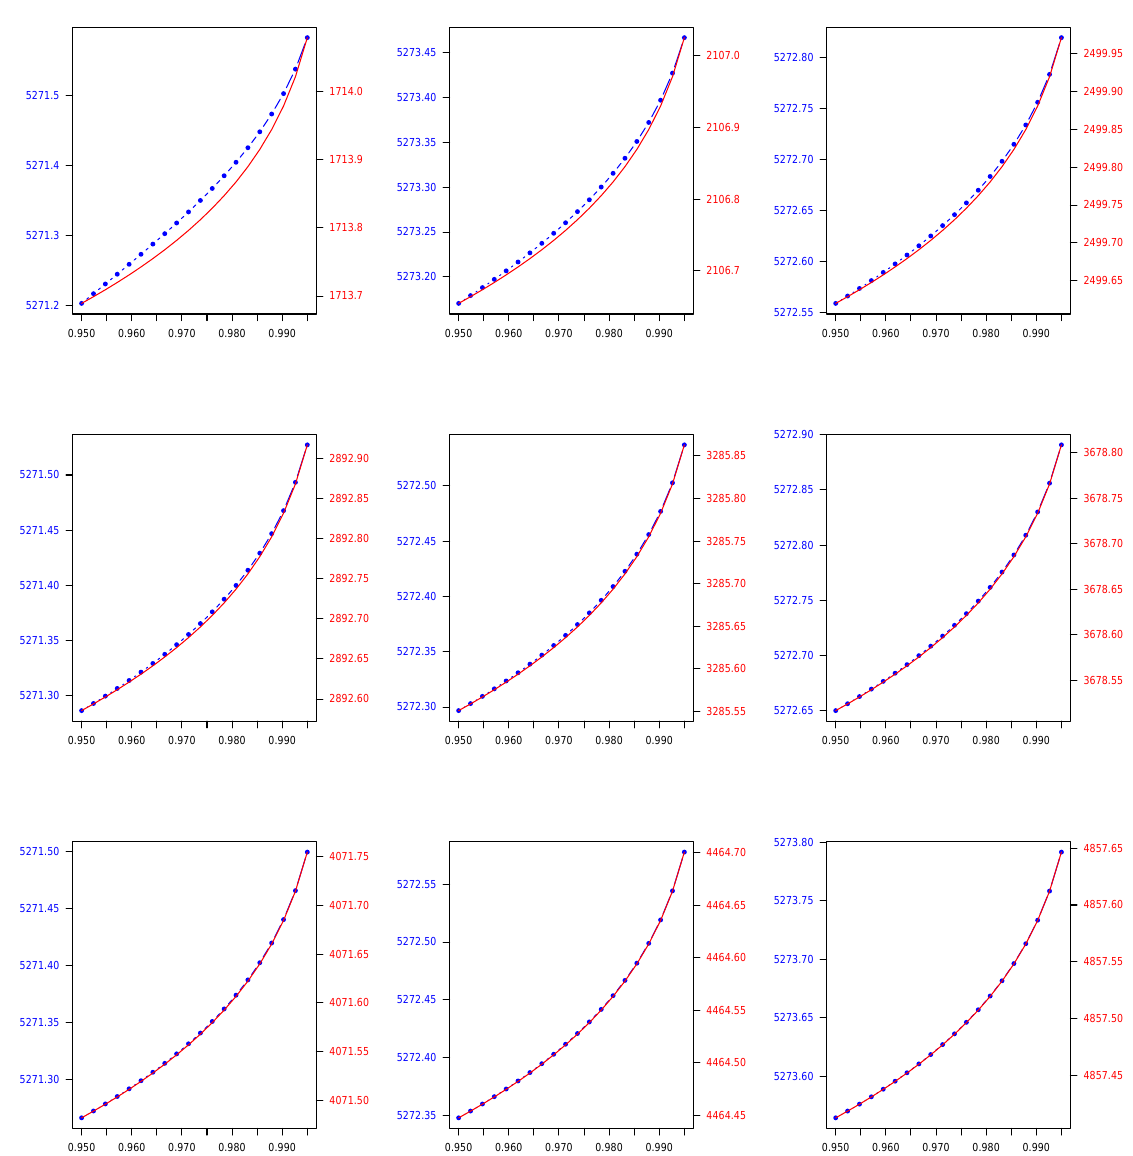
Figure 1. Two-component (2C) Normal finite mixture model-based (1 − α ) quantile Q mix . (blue colour) across all ( ˆ π 1 , ˆ π 2 ) combinations versus two-component (2C) Normal weighted average-based (1 − α ) quantile Q w . a . (red colour) across all ( π 1 , π 2 ) combinations, where (1 − α ) takes values in the range of 0.950-0.995. Note that, due to a considerable discrepancy between Q mix . and Q w . a . values, each given plot has two different y axes—one for each quantile